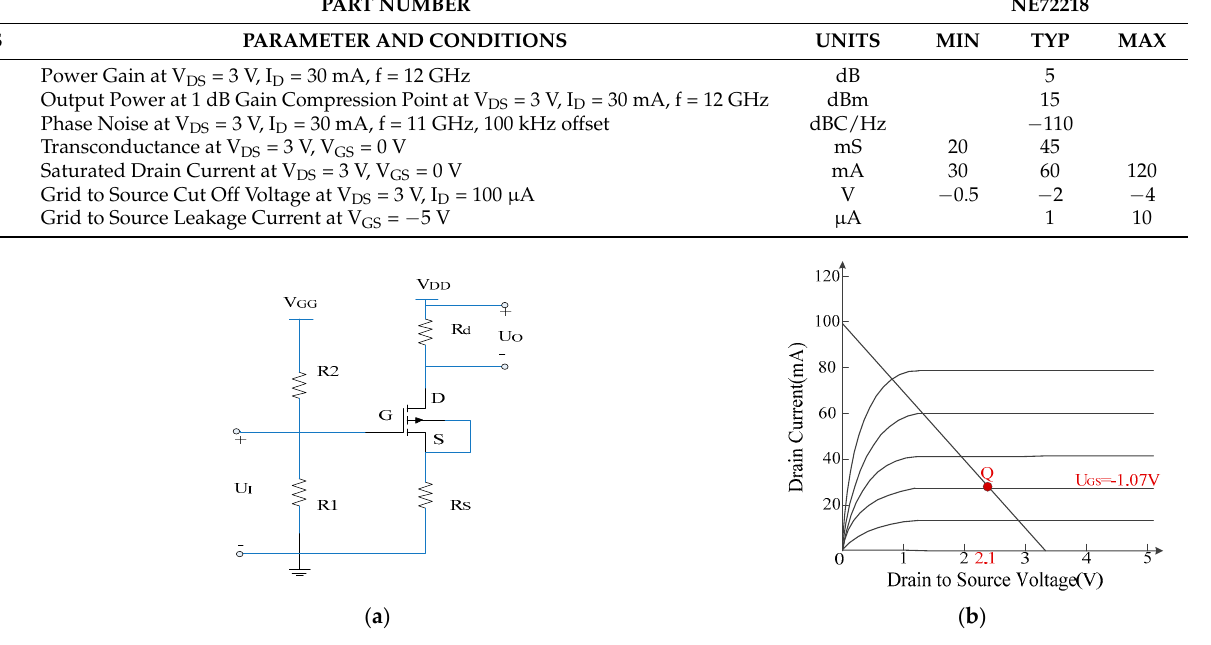
Figure 3. DC path of electro-optic modulation circuit ( a ) and the static operating point ( b ).